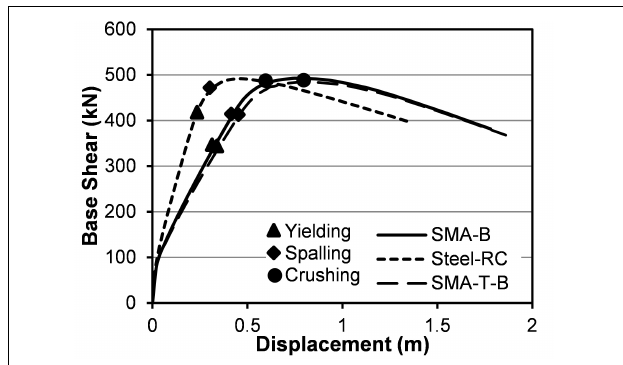
FIGURE 9 | Pushover response curves for steel and SMA reinforced bridge bents.